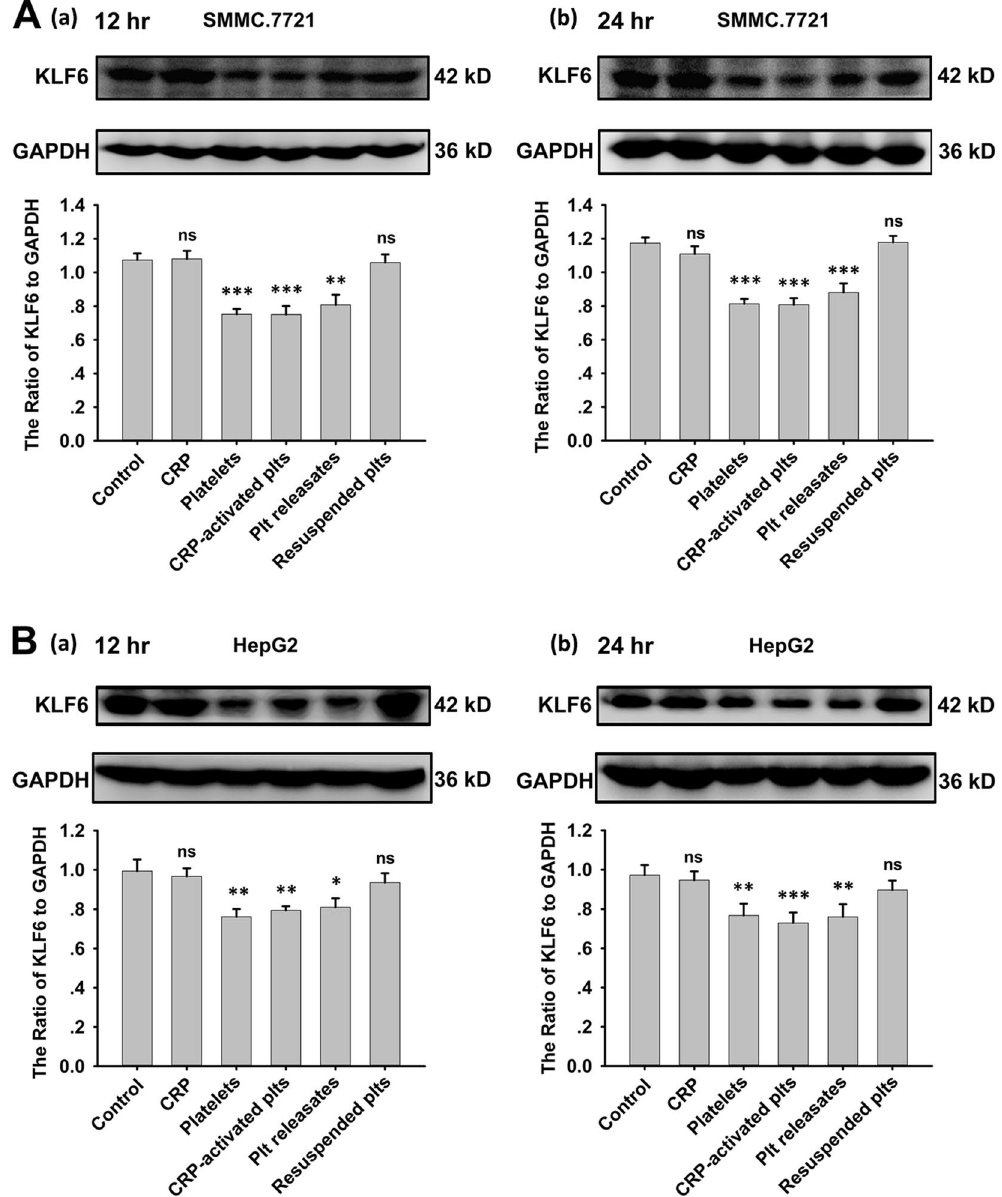
Figure 2. Expression of KLF6 in HCC cells was down-regulated by platelets. ( A,B ) After incubation with resting platelets, CRP-activated platelets, platelets releasates, and the resuspended platelets pellets for 12 (a) or 24 (b) hours, KLF6 expression in SMMC.7721 ( A ) and HepG2 ( B ) cells was measured by a Western blot analysis. A quantitative analysis of the ratio of KLF6 to GAPDH expression is shown, and data are presented as the mean ± SEM (n = 9 for SMMC.7721, and n = 8 for HepG2, ** p < 0.01 and *** p < 0.001 compared with